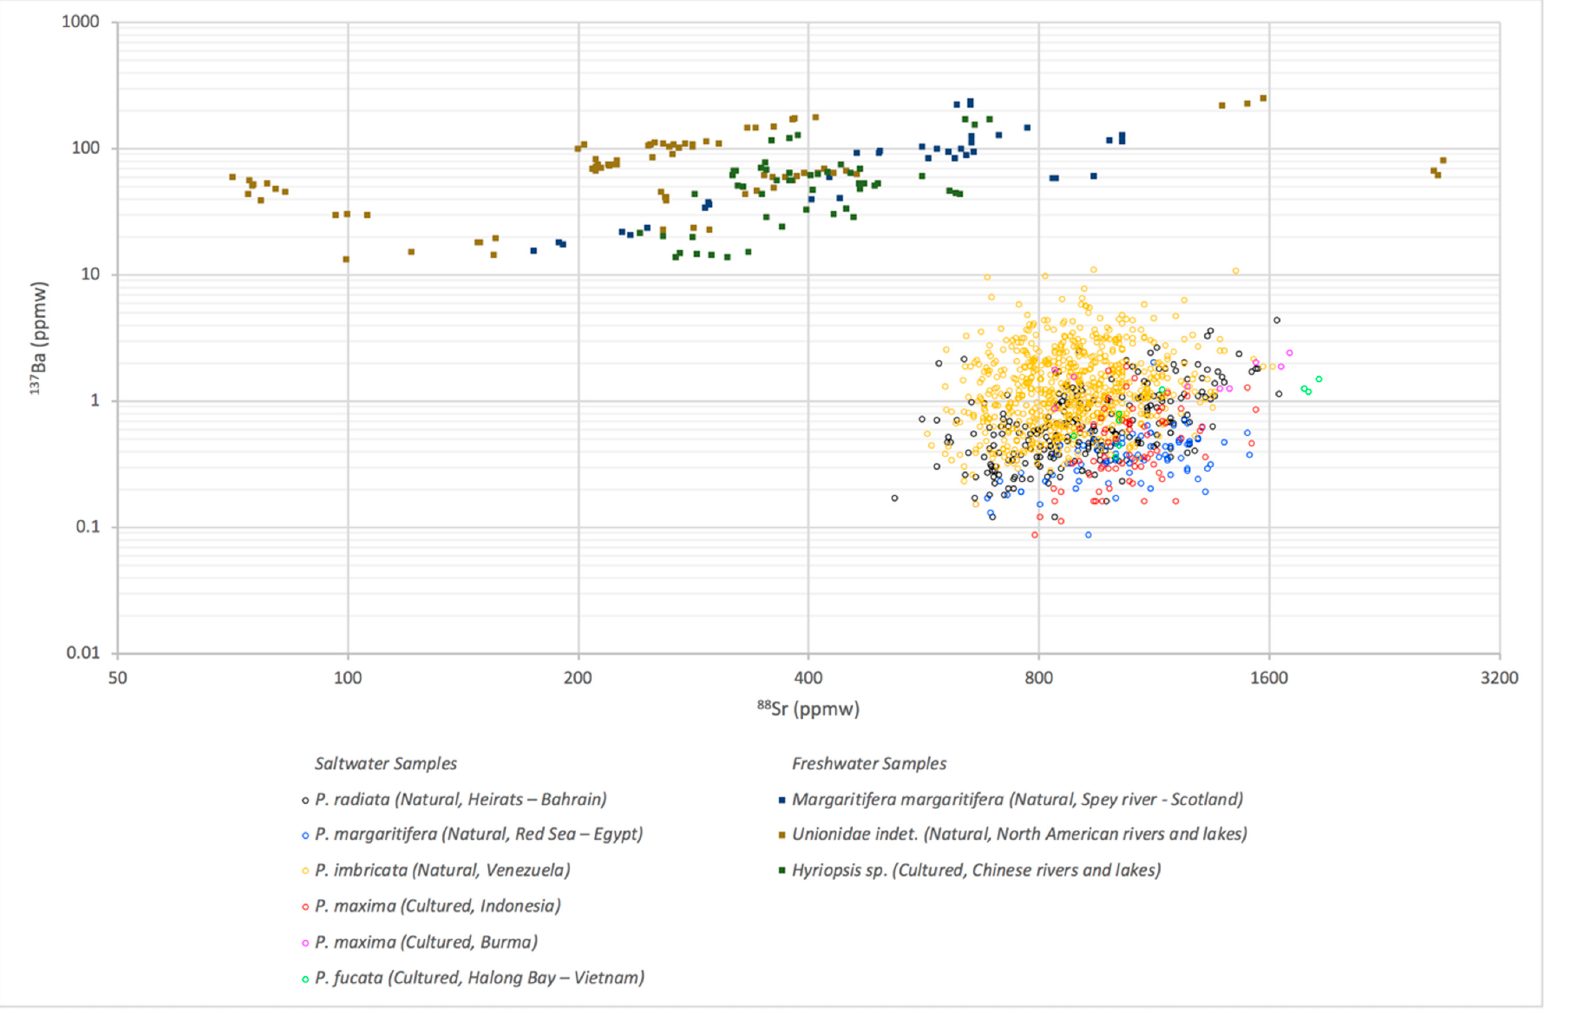
Figure 3. Binary plot of 88 Sr vs. 137 Ba of the studied samples.